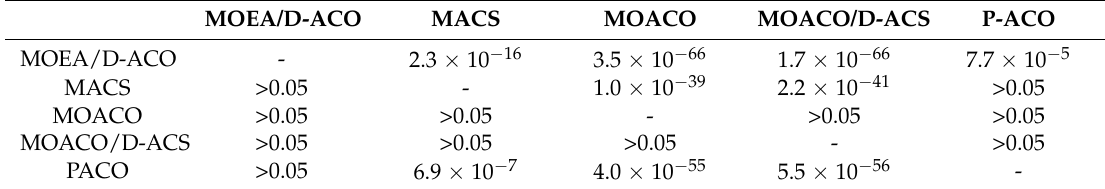
Table 7. Kruskal–Wallis test on kroCE100 based on H-indicator.